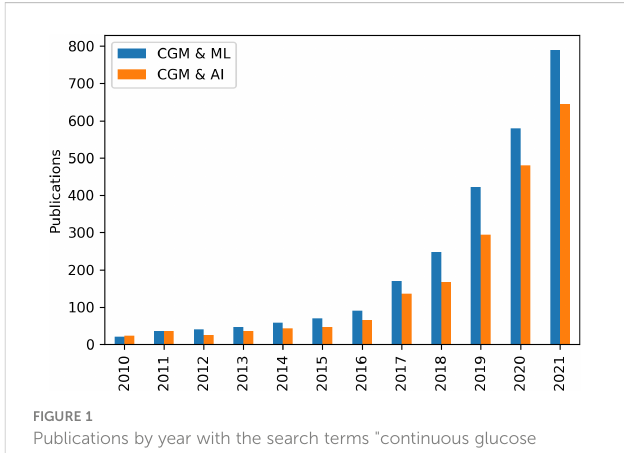
FIGURE 1 Publications by year with the search terms "continuous